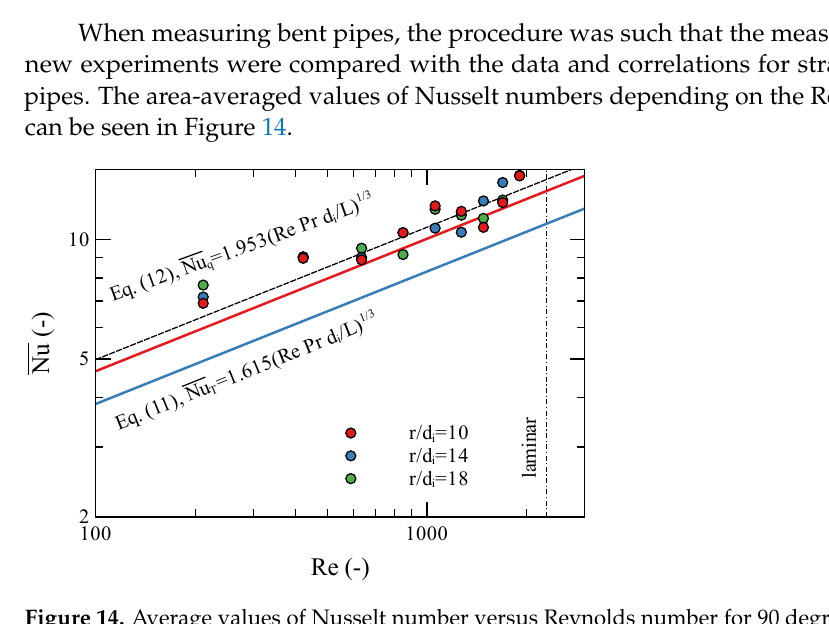
Figure 14. Average values of Nusselt number versus Reynolds number for 90 degree bent pipes. The dashed black line represents the regression of all measured